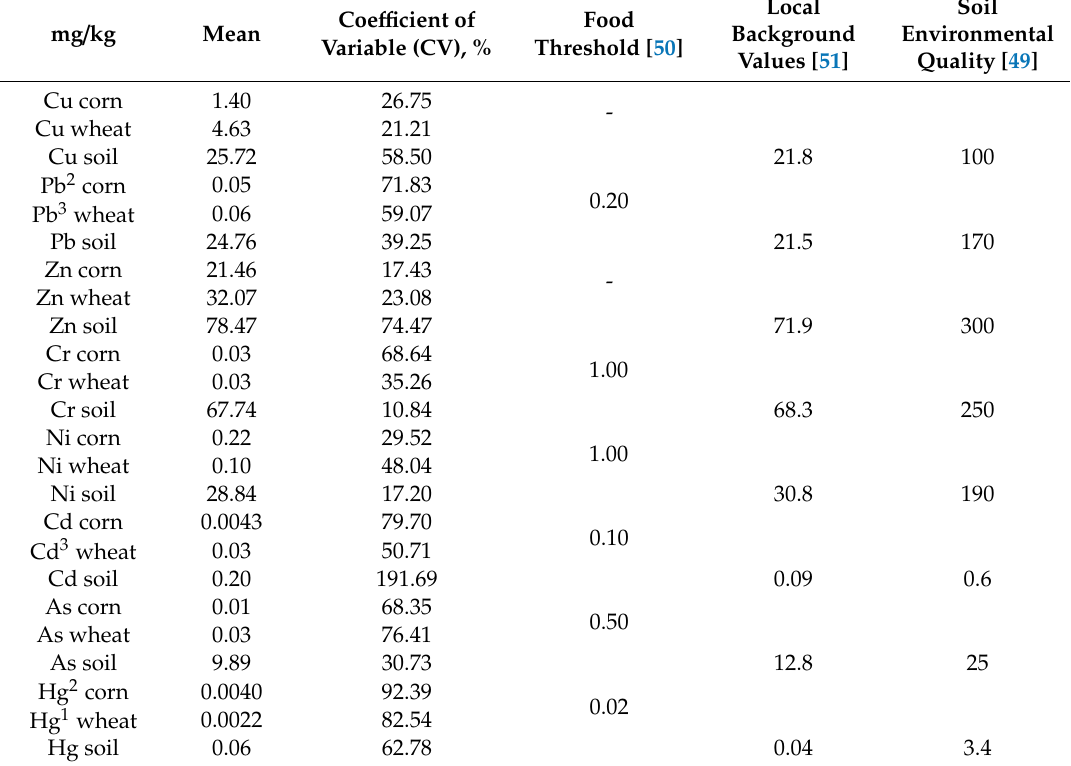
Table 1. Comprehensive statistical analysis for wheat, corn, and